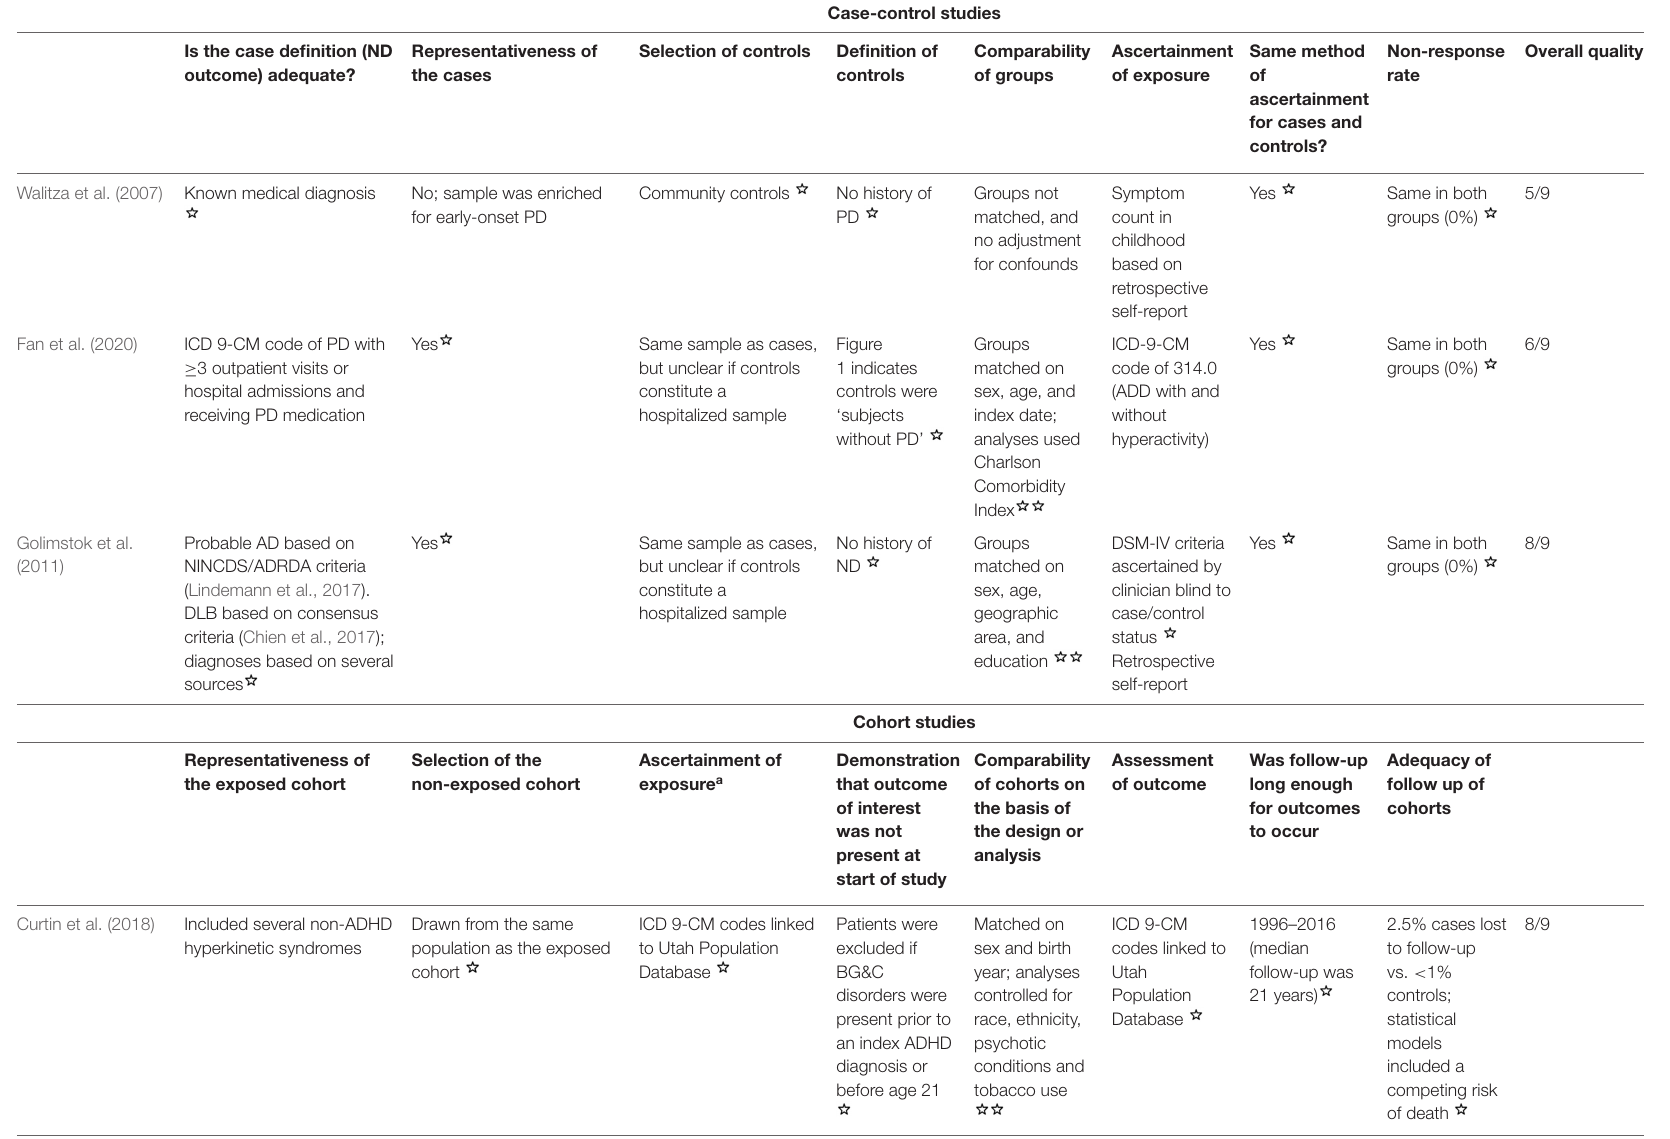
TABLE 2 | Evaluation of the quality of the eight studies in this review using the Newcastle-Ottawa